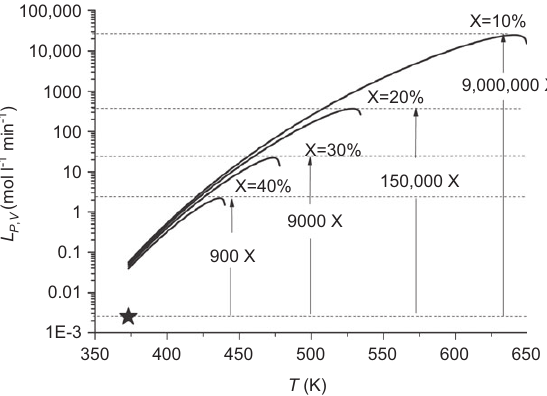
Figure 4 Specific performance L ture (T) representative for the determination of the optimal novel process window at P = 10 bar, C The conventional batch process is represented by the star.